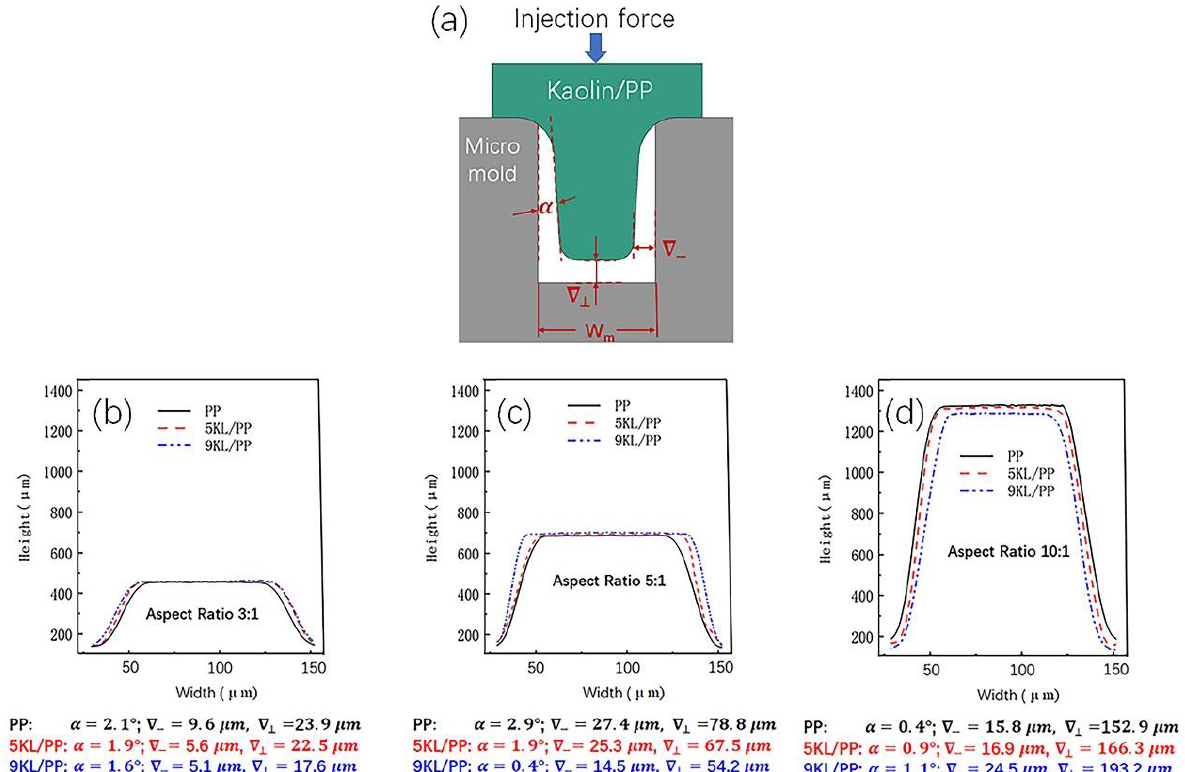
Figure 5. Geometry of the kaolin/PP composite ( a ) microstructured prismatic samples, with aspect ratios of ( b ) 3:1, ( c ) 5:1 and ( d ) 10:1.